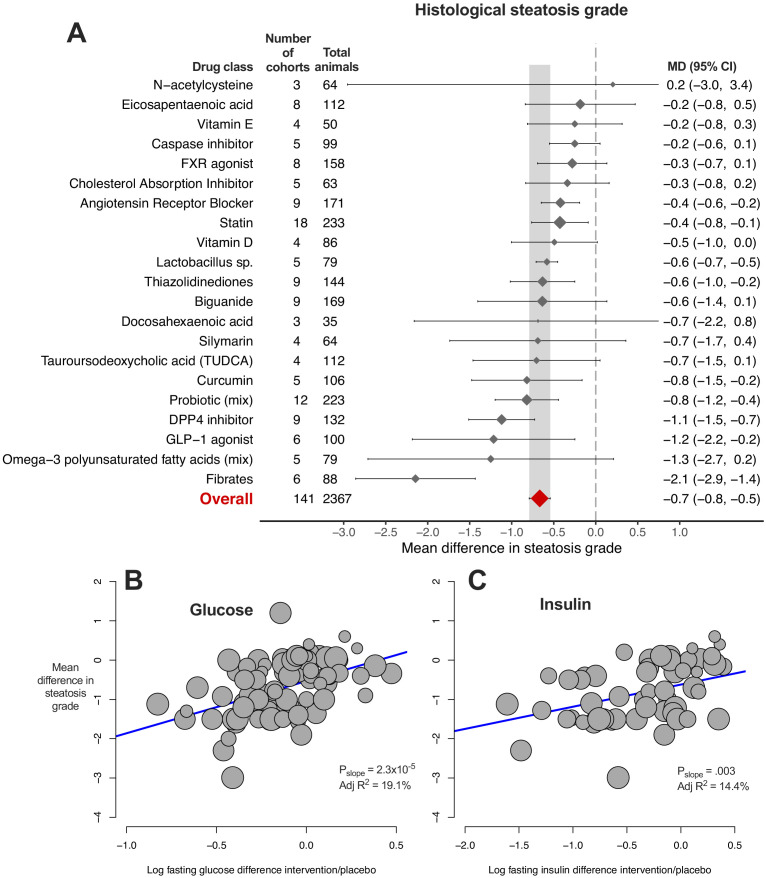
Meta-analysis of steatosis grade in rodent studies of NAFLD.(A) Forest plot with subgrouping by class of drug. Individual studies have been hidden and only subgroup summaries are illustrated. The total number of animals is calculated from the sum of control and interventional animals for each subgroup. CI, confidence interval; DPP4, Dipeptidyl peptidase-4; FXR, Farnesoid X receptor; GLP-1, Glucagon-like peptide-1; MD, mean difference; TUDCA, Tauroursodeoxycholic acid. (B) Meta-regression bubble plot using (log) difference in fasting glucose between interventional and control animals, after removal of studies using models that induce weight loss. (C) Meta-regression bubble plot using (log) difference in fasting insulin between interventional and control animals, after removal of studies using models that induce weight loss.Figure 4—source data 1.Results of meta-analysis and meta-regression of steatosis grade in rodent studies of NAFLD.Tab 1. Results from meta-analysis of steatosis grade with subgroup by drug class. Tab 2. Results from meta-analysis of steatosis grade with subgroup by individual drug. Tab 3. Results from meta-analysis of steatosis grade with subgroup by drug class, after removal of outlier studies. Tab 4. Results from univariable meta-regression analyses. Tab 5. Results from model 1 (without drug) and model 2 (including drug class used) multivariable meta-regression analyses.